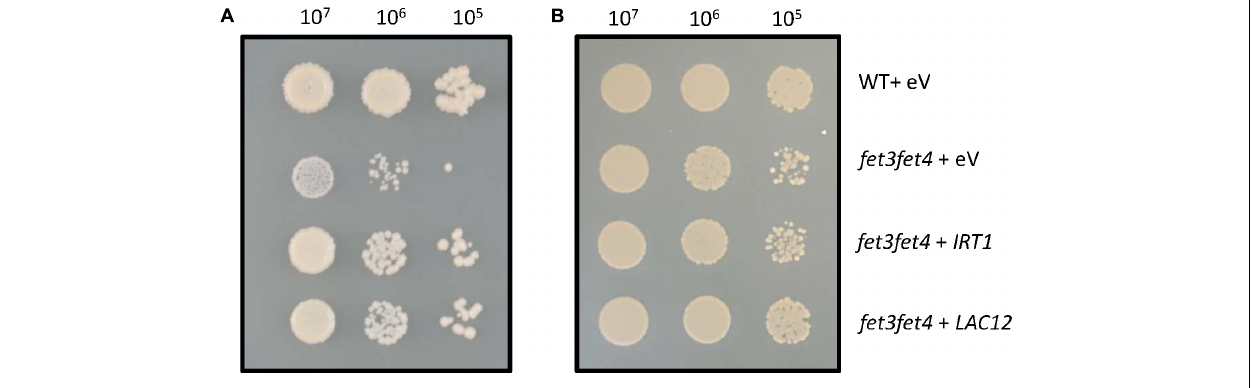
FIGURE 2 | Heterologous expression of the AtLAC12 cDNA complements a Fe uptake-defective fet3fet4 mutant of Saccharomyces cerevisiae . Wild-type and the Fe uptake-defective fet3fet4 mutant of Saccharomyces cerevisiae transformed with the empty vector pFL61 Gateway (eV) or expressing IRT1 or LAC12 cDNAs of A. thaliana , respectively. Aliquots of 10 µ L of 10-fold serial dilutions (starting from OD 600 = 0.3, ca . 10 7 cells ml − 1 ) were spotted on (A) SD-URA medium (pH 5.7) and (B) SD-URA medium (pH 5.7) supplemented with 0.5 mM FeSO 4 . Images are representative of three independent transformant colonies from each of two independent